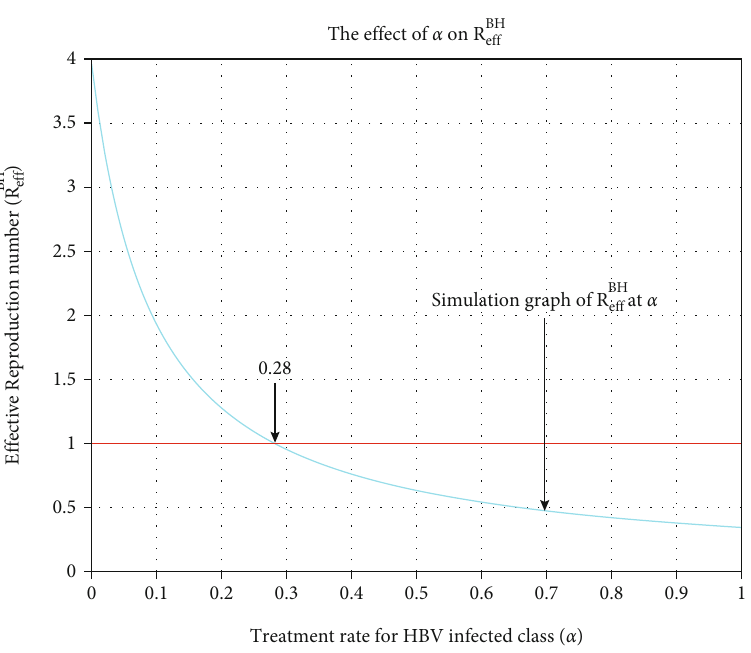
Figure 15: Simulation of the reproduction number of HBV-HIV/AIDS coinfection at variable treatment rate α